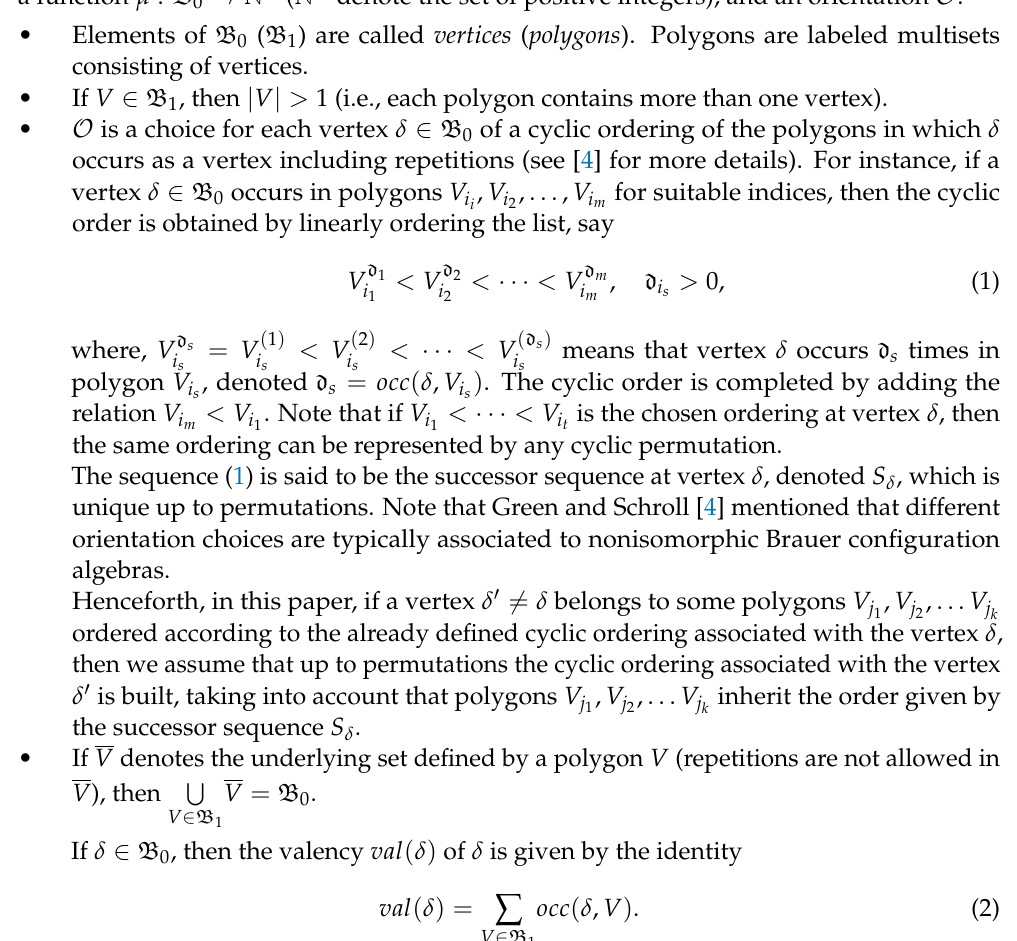
Algorithm 1 is a short version of an algorithm defined by Cañadas et al. in [5] to build a Brauer configuration